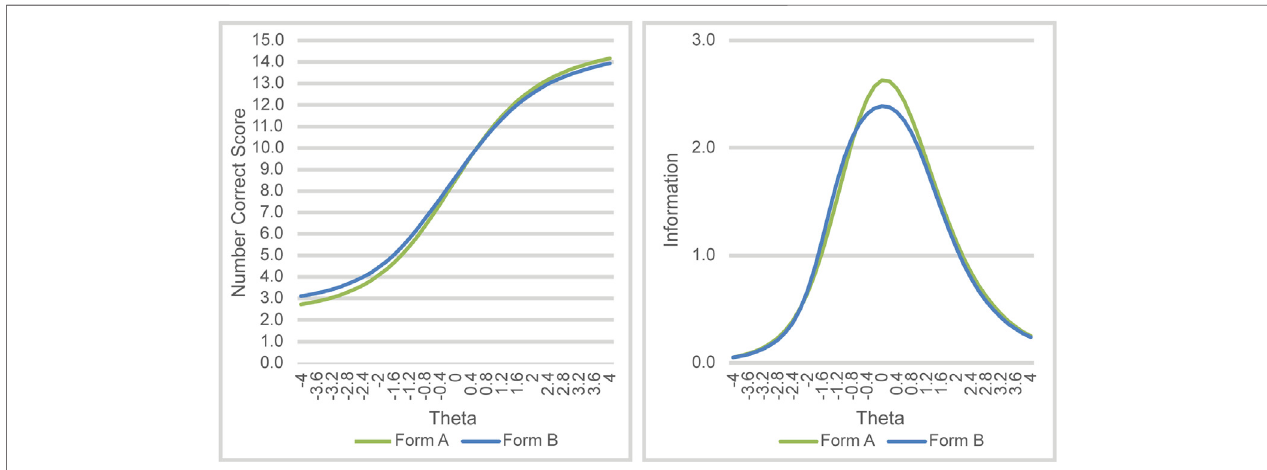
FIGURE 5 | Test characteristic (left) and information curves (right) for IMRB test forms A and